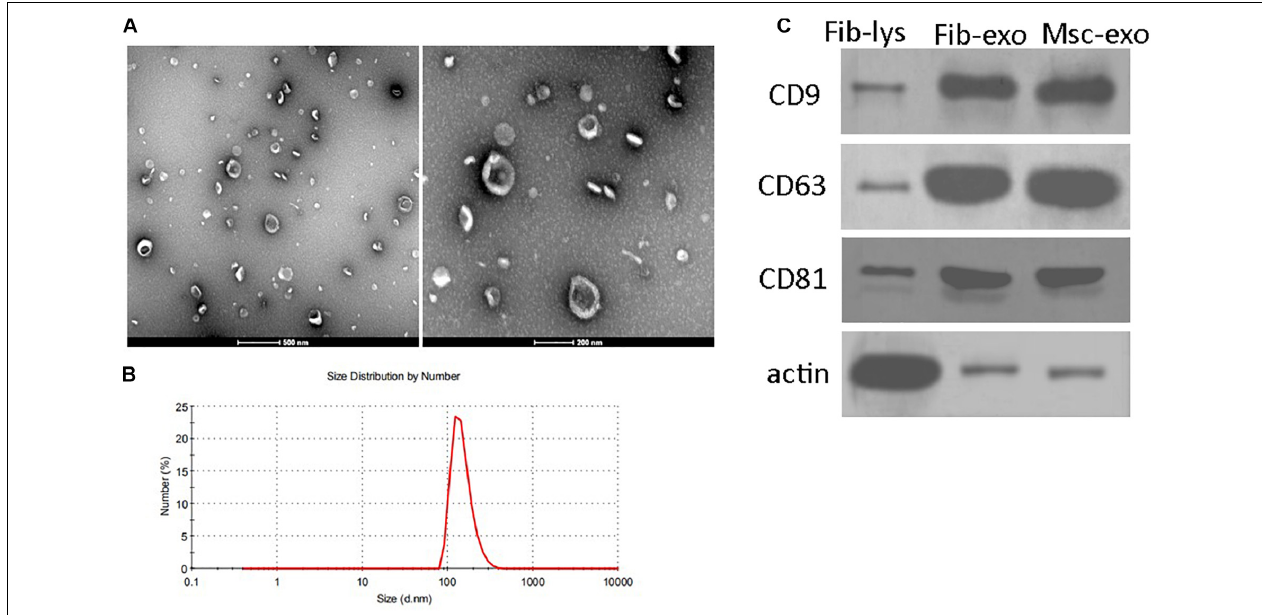
FIGURE 1 | Characteristics of human bone marrow–derived mesenchymal stem cell (hBMSC)–derived exosomes. (A) Representative images of hBMSC-derived exosomes under transmission electron microscopy. Scale bar: 500 and 200 nm. (B) Size distributions of hBMSC-derived exosomes determined by dynamic